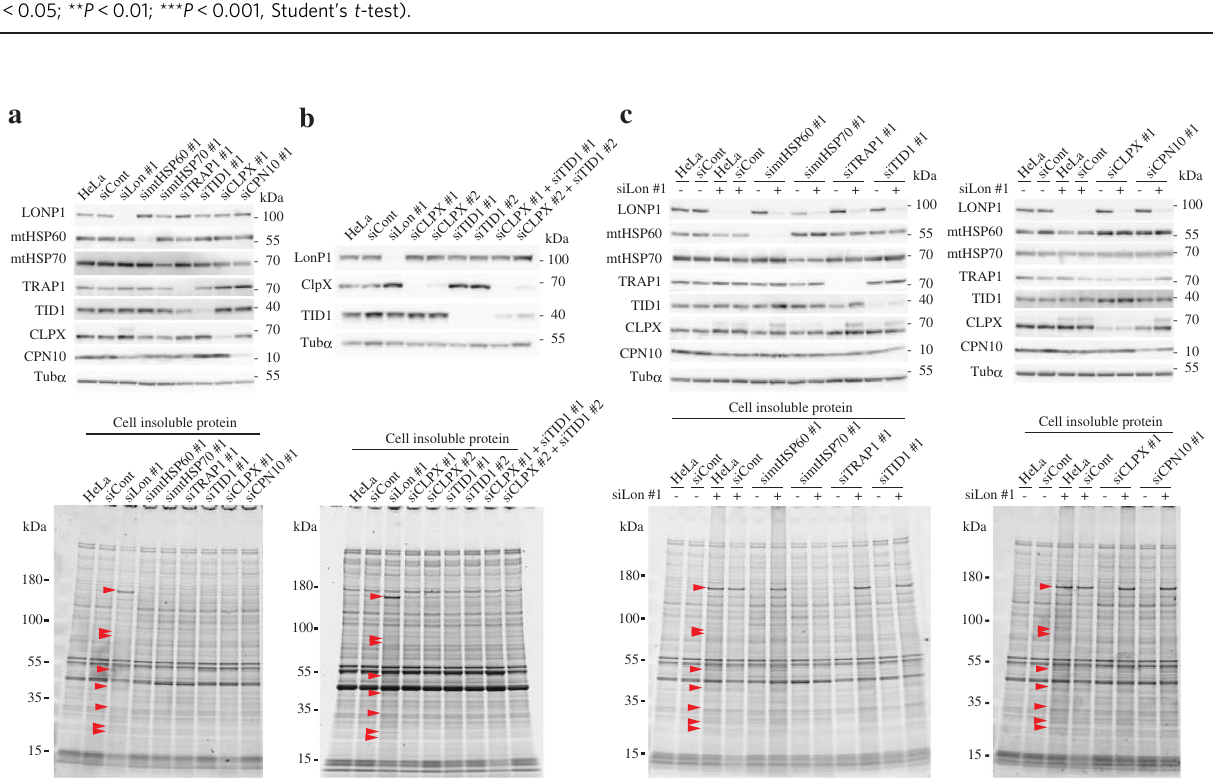
Fig. 1 Analysis of aggregated proteins in LONP1 knockdown HeLa cells. Analysis of proteins from non-transfected HeLa cells (HeLa) or HeLa cells treated